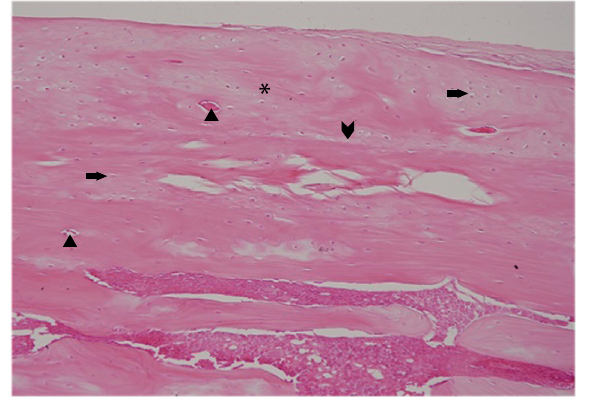
Figure 2. Non-homogenous bone matrix, osteocytes, and calcification line at 8th week